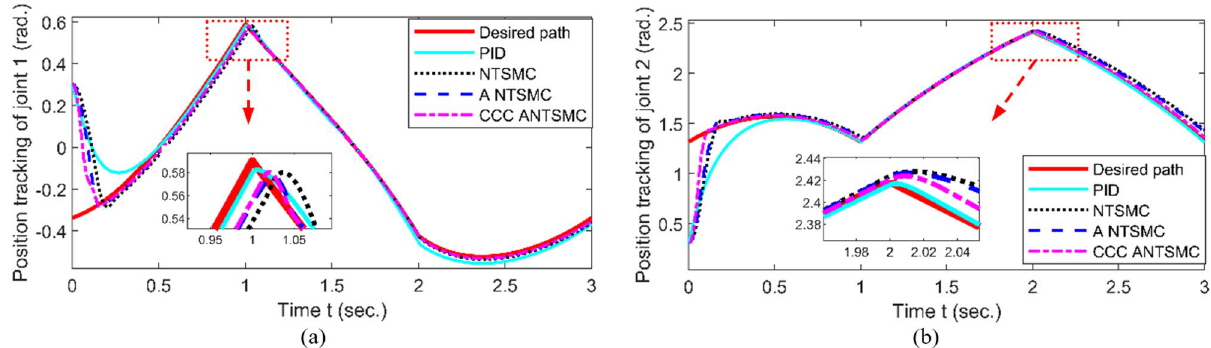
Figure 6. Trajectory tracking in joint space (a. Joint 1#, b. Joint